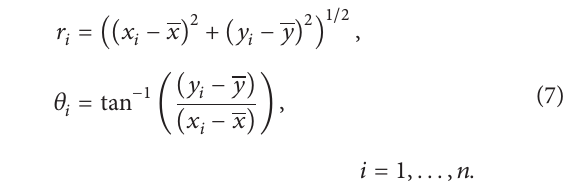
The curve in Figure 3(a) is fitted using a smoothing spline, but ure 3(b) are fitted using smoothing splines with change